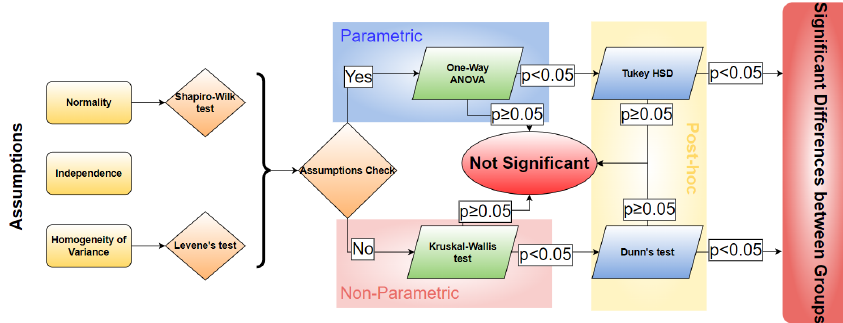
Figure 17. Pipeline of the statistical analysis of the data gathered in the human